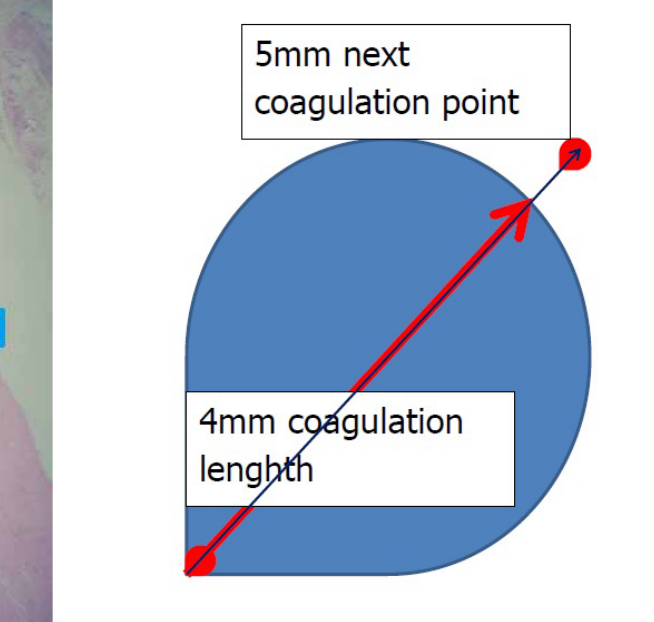
Figure 3: Schematic recommendation for coagulation during